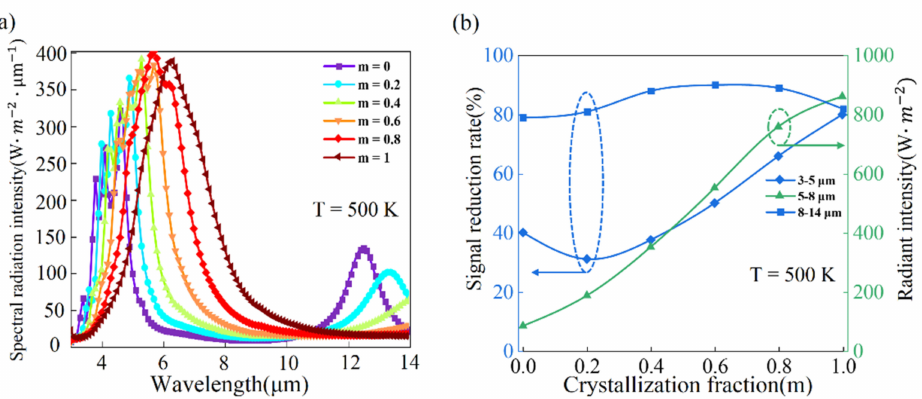
Figure 4. Tunability of the MIM thermal emitter as changing crystallization fraction of GST. ( a ) Spectral radiation intensity of the thermal emitter at corresponding various crystallization fraction in the normal direction at 500 K; ( b ) The IR signal reduction rates in wavelength ranges 3–5 µ m and 8–14 µ m and the radiant intensity in wavelength ranges 5–8 µ m at 500 K for different crystallization